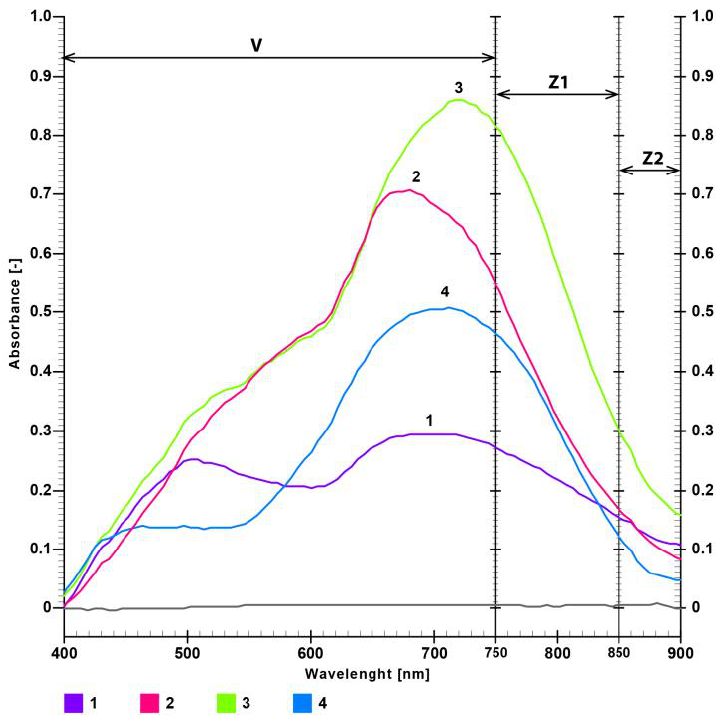
Figure 4. Dyes 1, 2, 3, and 4 (first row in Figure 1).